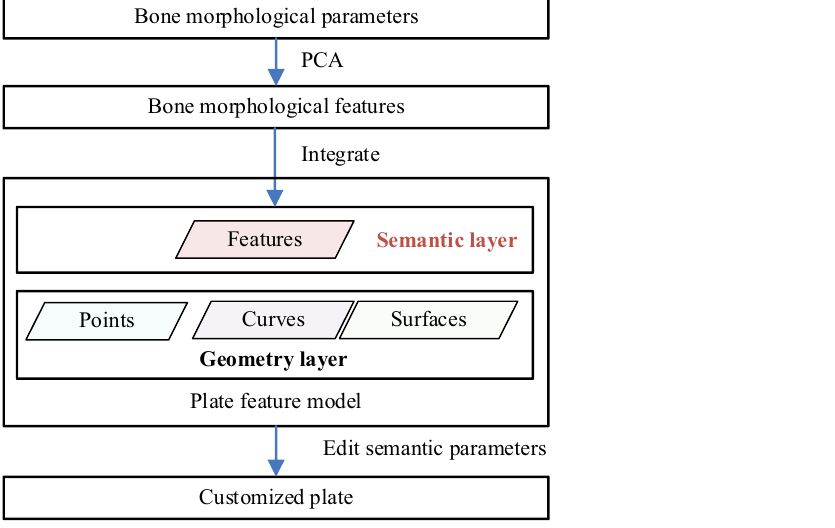
Figure 1. Workflow of the proposed